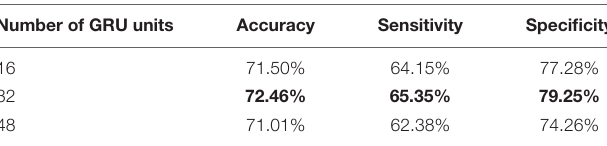
The bold values in this table represent the optimal values of accuracy, specificity and sensitivity.